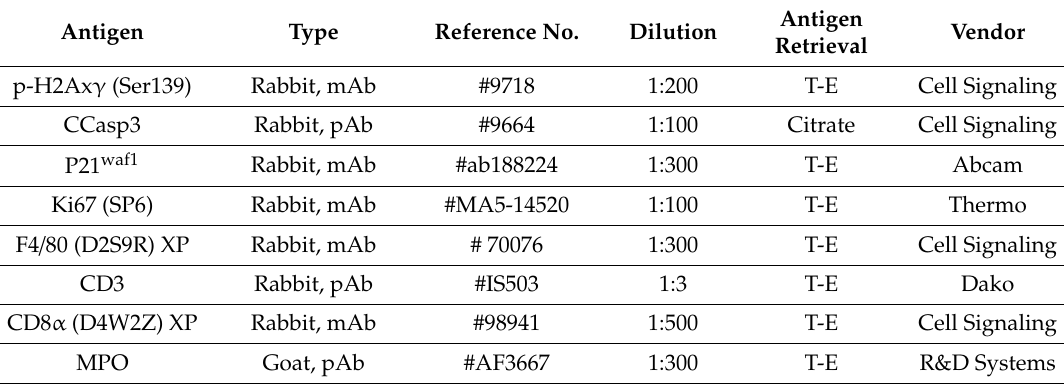
Table 1. Antibodies and conditions used for